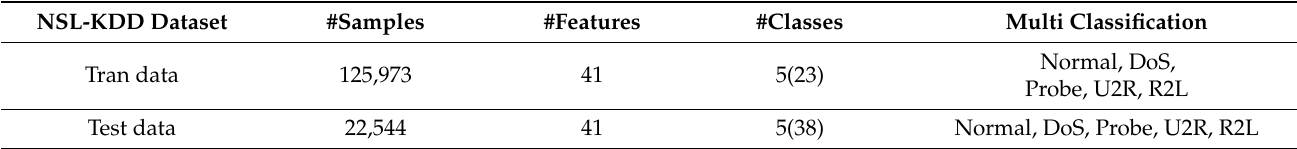
Table 3. Description of NSL-KDD Dataset.